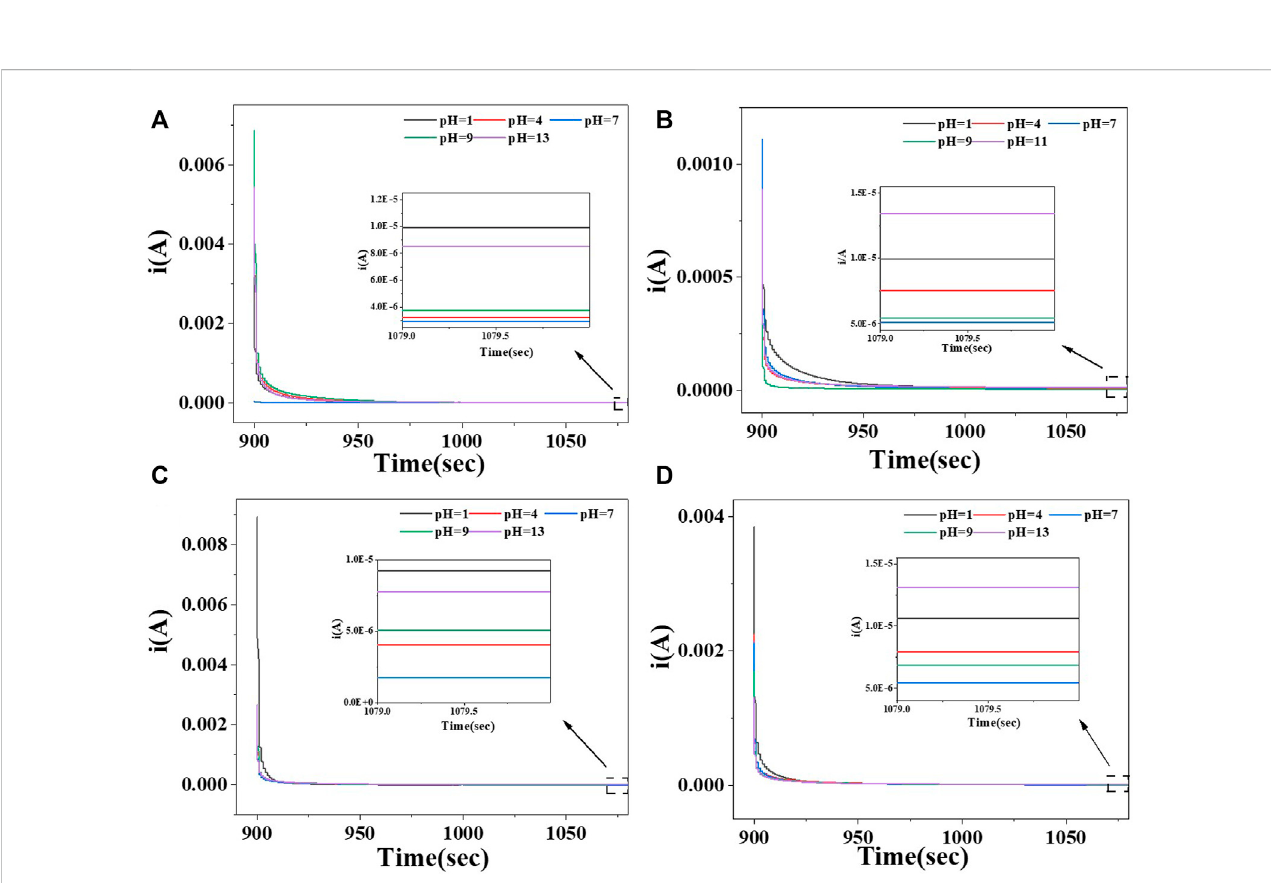
Steady current atdifferent pHvalue ofthestarch/CMC-1.0 composite fi lm. (A) : pureCS fi lm; (B) :CS/CMC-1.0composite fi lm; (C) :pureCA fi lm; (D) :CA/ CMC-1.0 composite fi